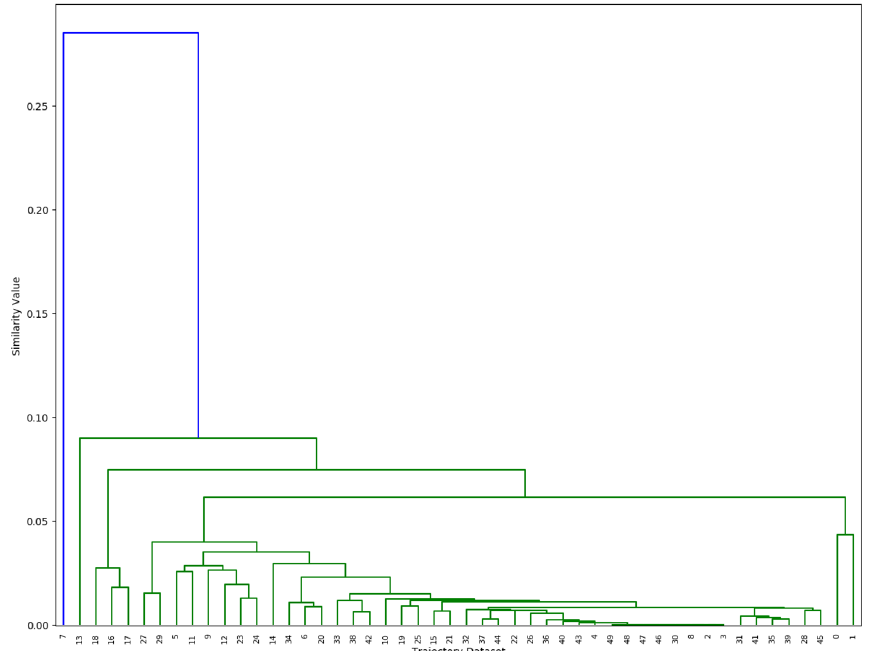
Figure 7. Hierarchical clustering dendrogram of 50 trajectories. Blue dendrogram is the longest trajectory in our